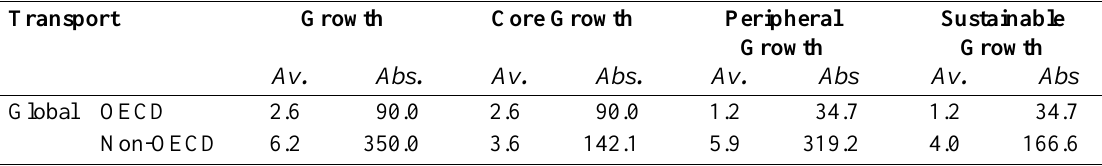
Table 7. Average annual GDP growth rates and absolute overall GDP growth rates between 1995 and 2020 (in %) Transport Growth Core Growth Peripheral Sustainable Growth Growth Av. Abs. Av. Abs. Av. Abs Av. Abs Global OECD 2.6 90.0